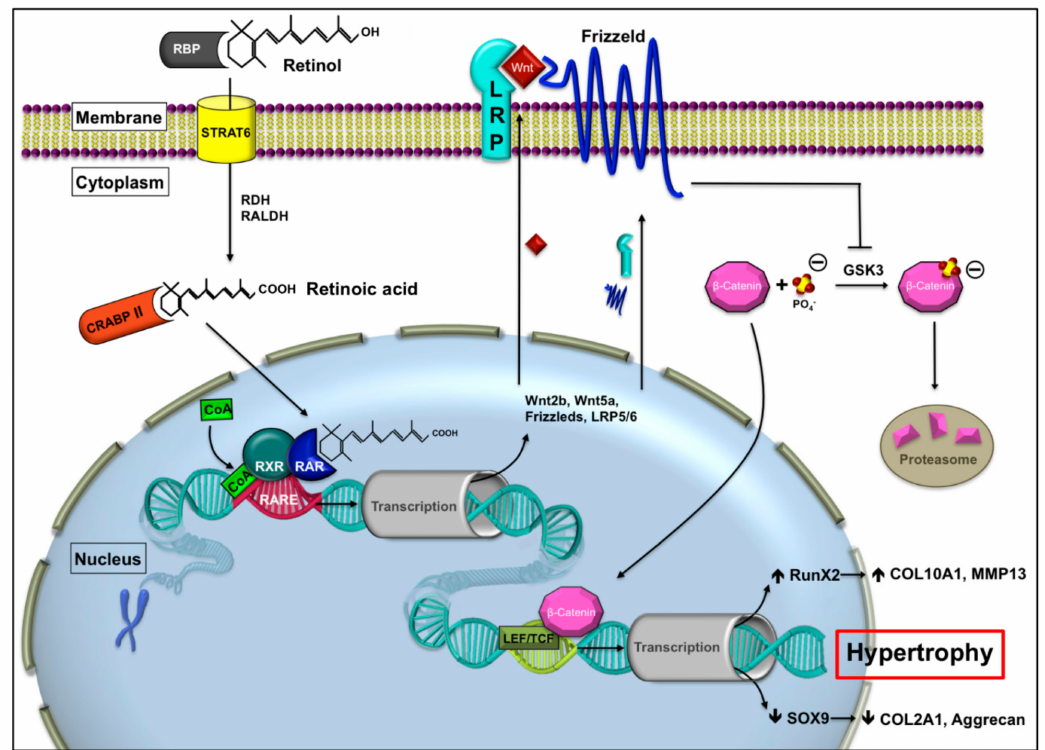
Figure 1. Potential interactions between retinoid signaling and the Wnt / β -catenin pathway on the cellular level for growth plate chondrocytes during endochondral ossification. The inactive retinol is transported to the cell by retinoid binding protein and translocated into the cytoplasm by the transporter STRAT6, where it is transformed into the active retinoic acid (RA) [19,37,38]. The retinoic acid is translocated into the nucleus by the cellular retinoic acid binding protein II (CRABP II) [39,40]. Binding of retinoic acid (RA) to the RA receptor would activate gene expression of Wnt proteins, receptors, and coreceptors which leads to an increased Wnt / β -catenin signaling followed by hypertrophic conversion [41]. RBP, retinoid binding protein; STRAT6, ”stimulated by retinoic acid“, receptor / Vit. A transporter; RDH, retinol dehydrogenase; RALDH, retinaldehyde dehydrogenase; RAR, retinoic acid receptor; RXR retinoic X receptor; CRABP II, cellular retinoic acid binding protein; RARE, retinoic acid response element; GSK3, glycogen synthase kinase 3 CoA co-activator; LRP, lipoprotein receptor related protein; LEF / TCF, lymphoid enhancer binding factor / transcription factor, ↑ , upregulation, ↓ ,